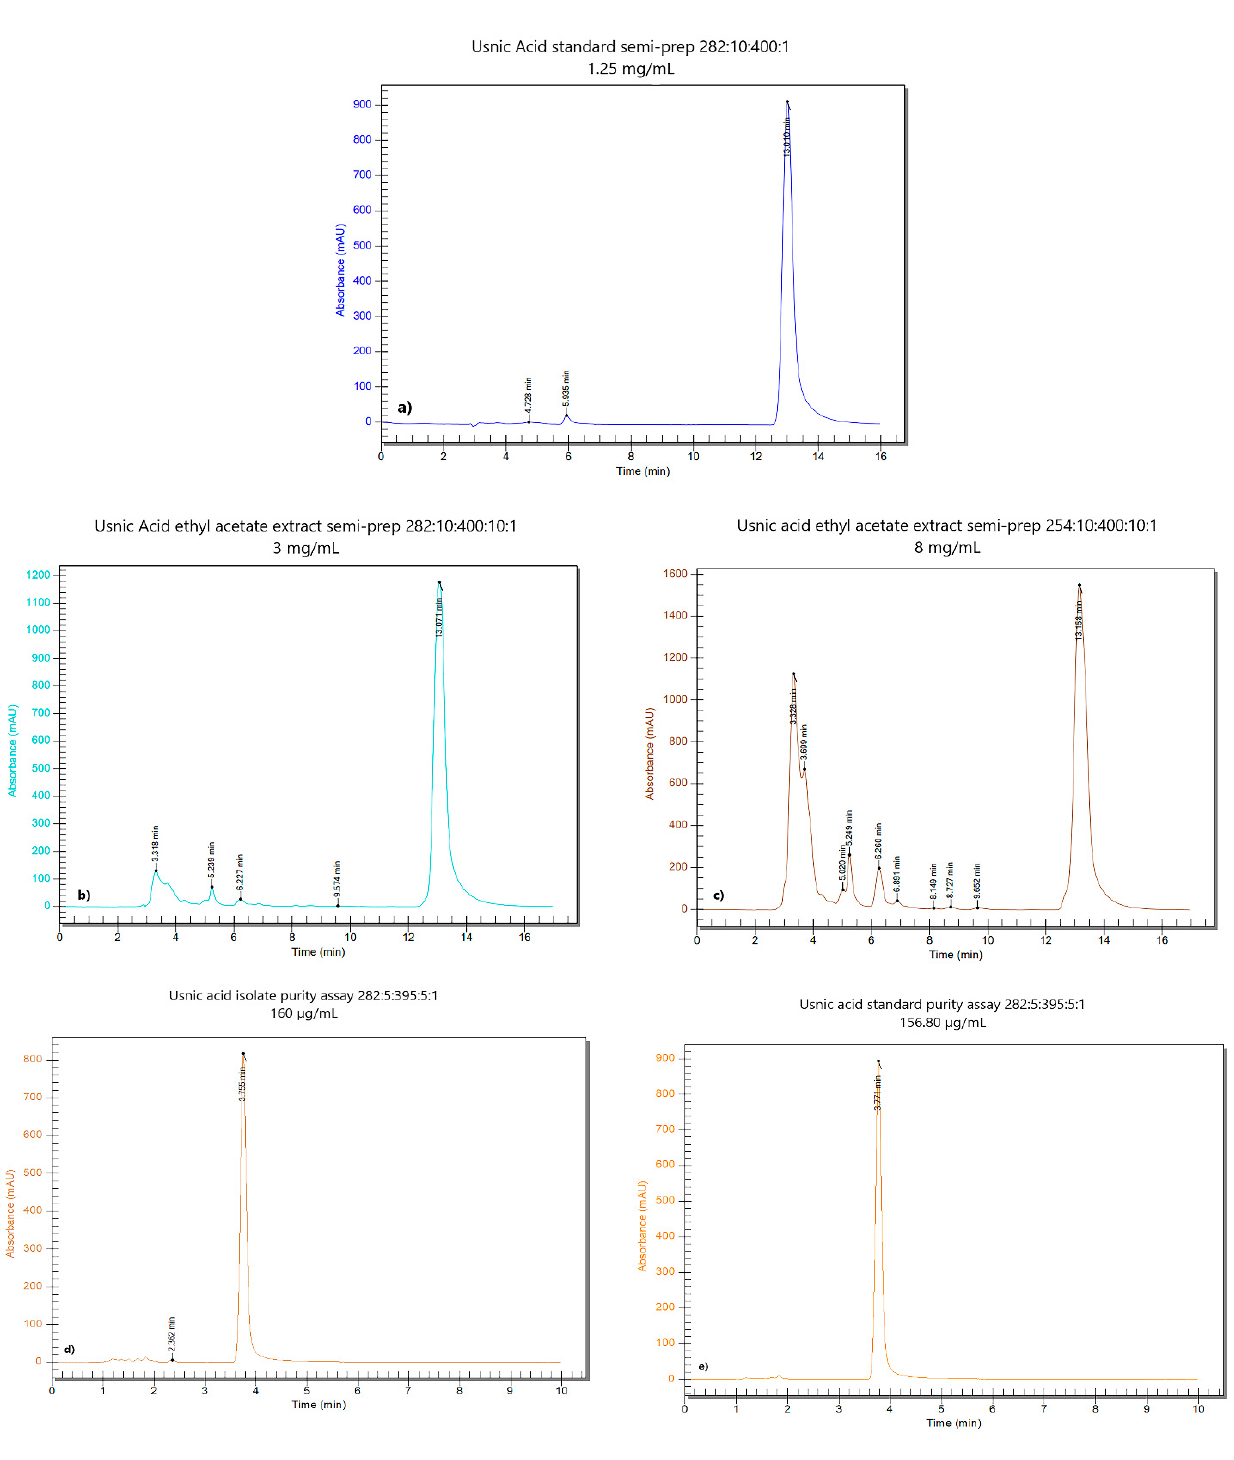
Figure 1. The chromatograms of usnic acid and sample solution for usnic acid separation; ( a – c ) chromatograms of usnic acid from semi-preparative chromatography, at the same flow rate (10 mL/min) and different wavelengths and concentrations: ( a ) usnic acid standard at 282 nm and 1.25 mg/mL; ( b ) usnic acid in UBEA at 282 nm and 3 mg/mL; ( c ) usnic acid in UBEA at 254 nm and 8 mg/mL; ( d , e ) chromatograms obtained at 282 nm from purity determination of isolated usnic acid: ( d ) sample solution (usnic acid isolate) ( e ) usnic acid standard solution.